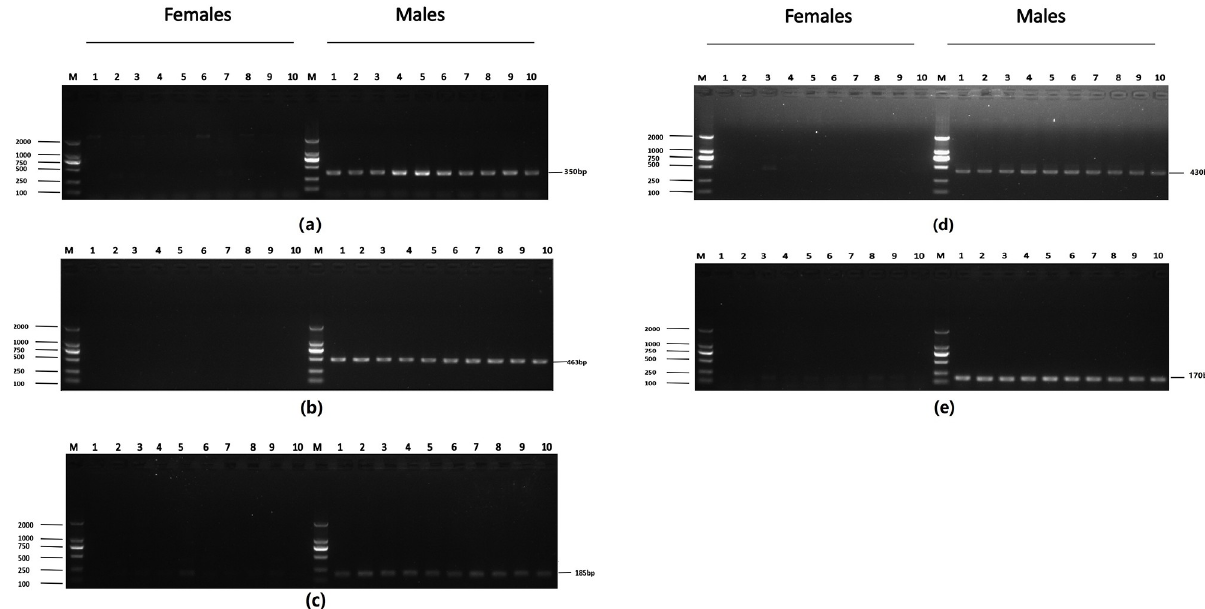
Fig 2. Identification of five male-specific tags: (a) DNA fragment amplified with Tag8736997; (b) DNA fragment amplified with Tag8743751; (c) DNA fragment amplified with Tag8821742; (d) DNA fragment amplified with Tag8818409; (e) DNA fragment amplified with Tag8821444; the left shows DL 2000 DNA marker sizes; the right shows fragment sizes.